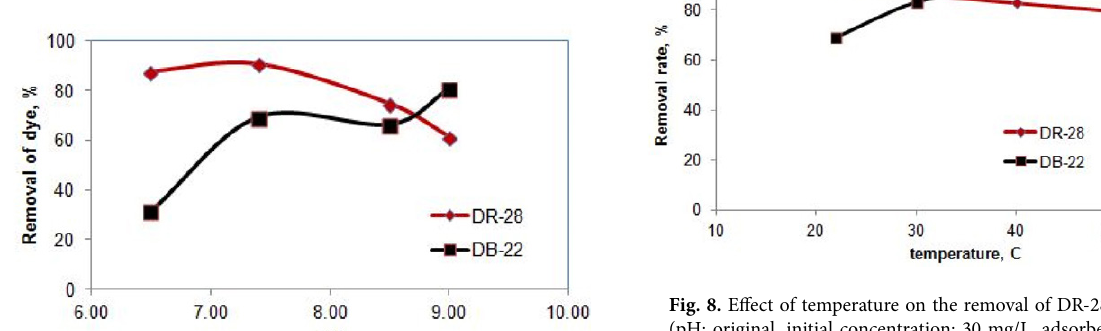
Fındık: Removal of Diazo Dye Direct Red 28 and Tetra ...